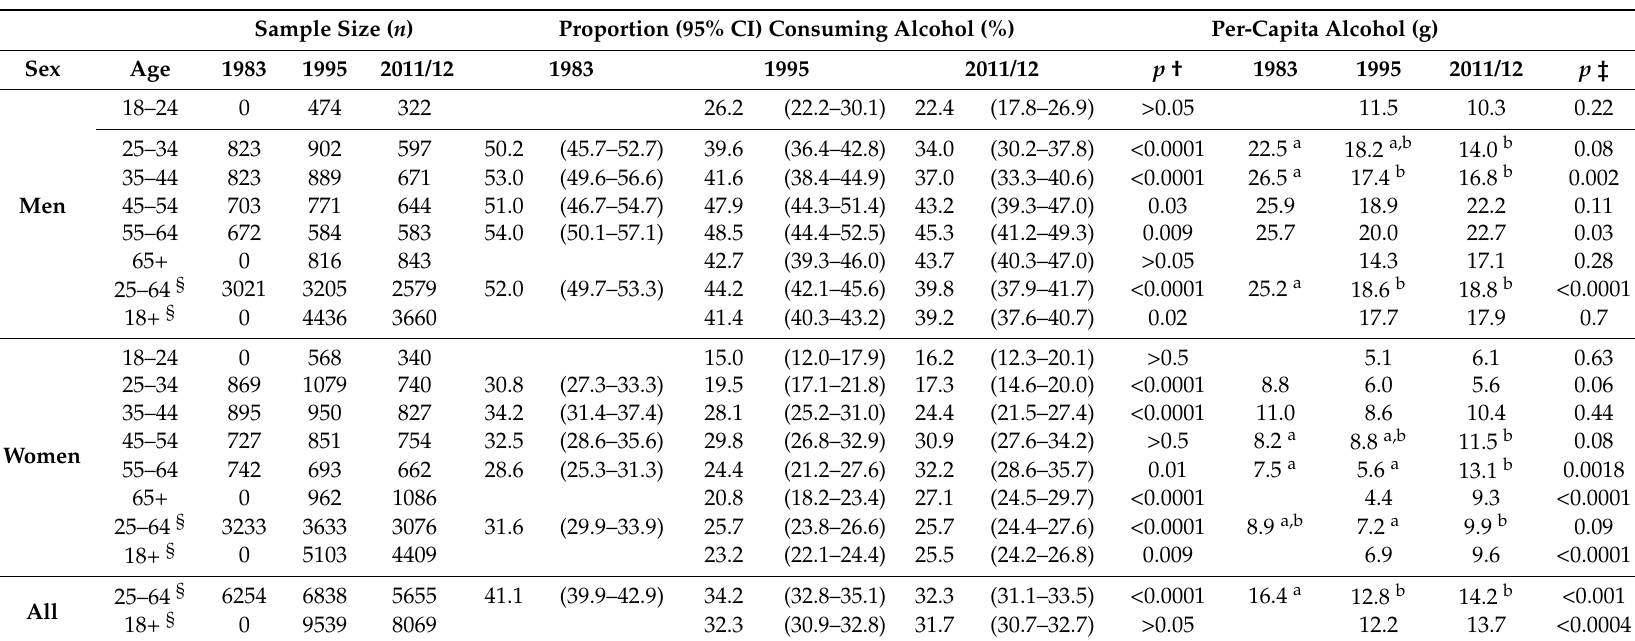
Table 2. Age-standardized proportion of people reporting alcohol and per-capita (mean) intake of pure alcohol (g) for men and women aged 18 years old in Australian national nutrition surveys conducted 1983, 1995, and 2011/12